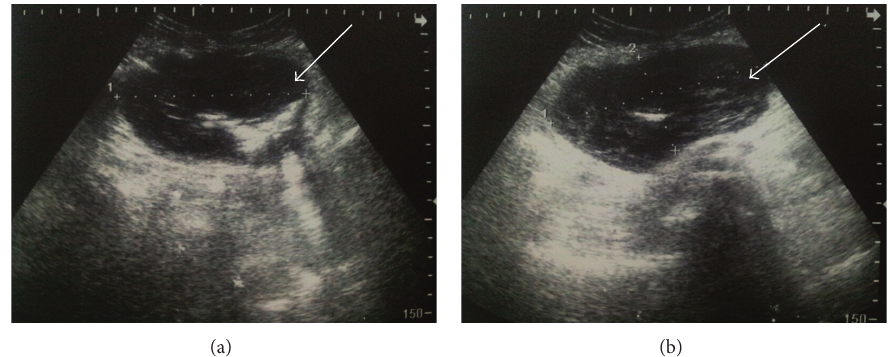
Figure 1: Abdomen USG. 114×52×99 mm sized hypoechogenic mass lesion in front of the main vascular structures in the abdomen midline in USG with calcification focuses inside (marked with an arrow).